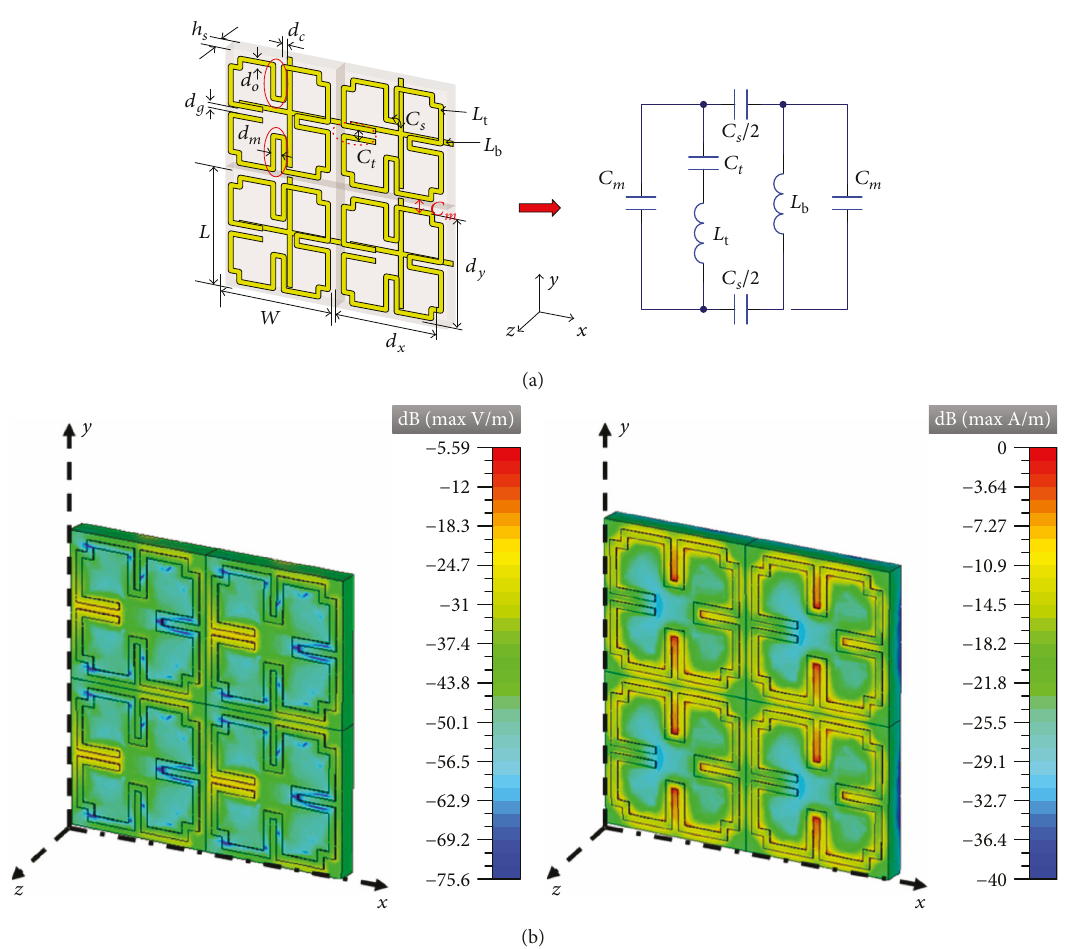
Figure 1: (a) WBLHM geometry and equivalent circuit W = L =5.5 mm, d d =0.25mm. (b) Electric fi eld (left) and magnetic fi eld (right) distribution in cross-section m Table 1: E ff ect OF d (mm) Value of d g